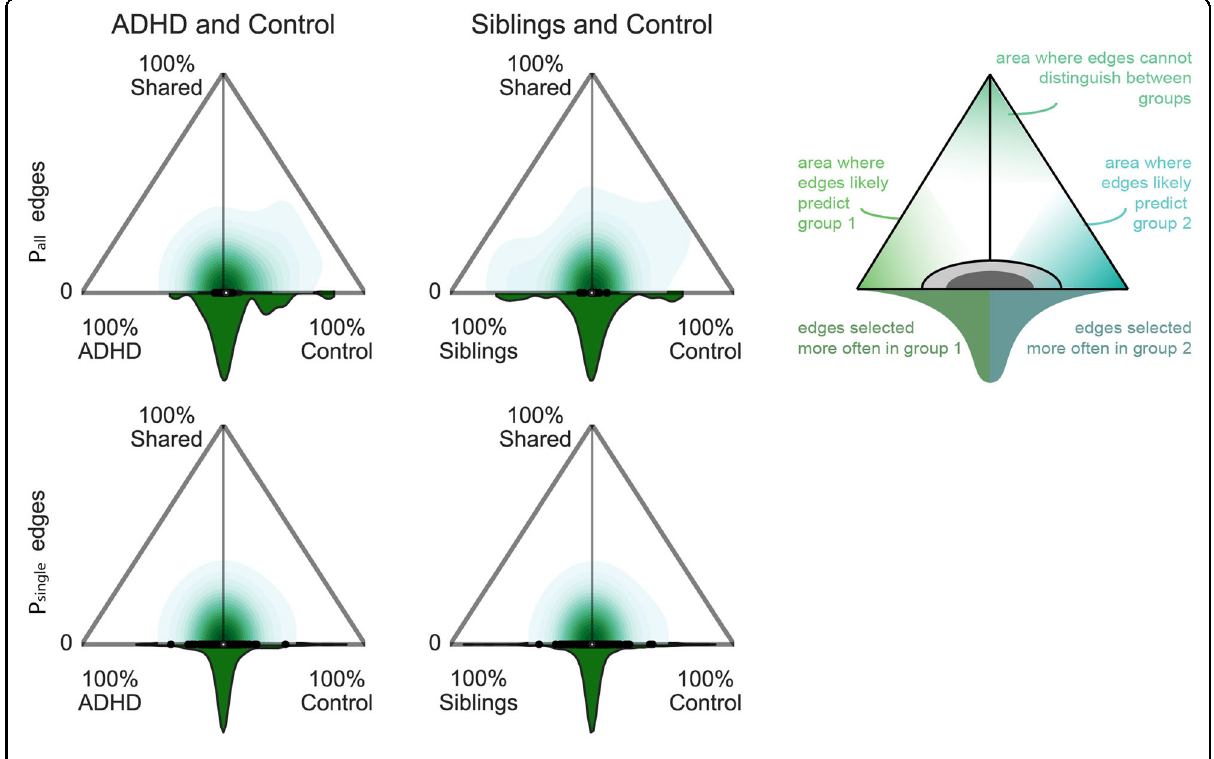
Fig. 2 Comparison of selection reliability across bootstraps. By investigating the reproducibility of the selection of connections across bootstraps for each group and connections, we inferred on the uniqueness ( x -axis) and shareability ( y -axis) of each connection between two groups. Y -axis represents the percentage of bootstraps in which a connection is selected in two groups as a common or task speci fi c connection, relatively. X -axis represents the difference between groups in percentage of selection across bootstraps of a connection as P all or P single edges. A connection that was always selected in both groups, i.e. high shareability, shown at the top corner of each triangle, would represent a connection that cannot be used to differentiate between those two groups. A connection that was always selected in one group only, located in the lower corners of the triangles, would be unique to a group and could be used to predict the group. Connections that would be heterogeneously selected in the population would have a low uniqueness (around 0 on the x -axis) and a low shareability (bottom of y -axis). The distribution at the basis of the triangle informs about the density of connections represented in the triangle, i.e. the spread of the distribution indicates whether only a small subset or a larger representation of connections are most often selected in one group relatively to the total amount of selected